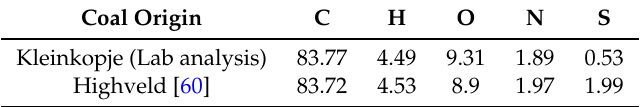
Table 3. Ultimate analysis (weight % dmmf basis).